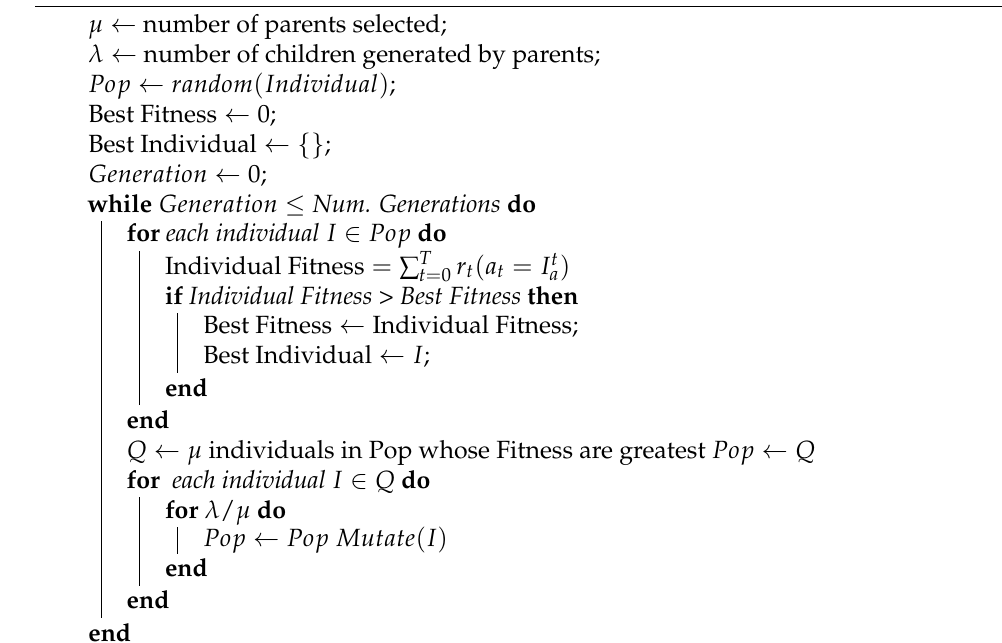
Algorithm 1: ( µ + λ ) -Evolutionary